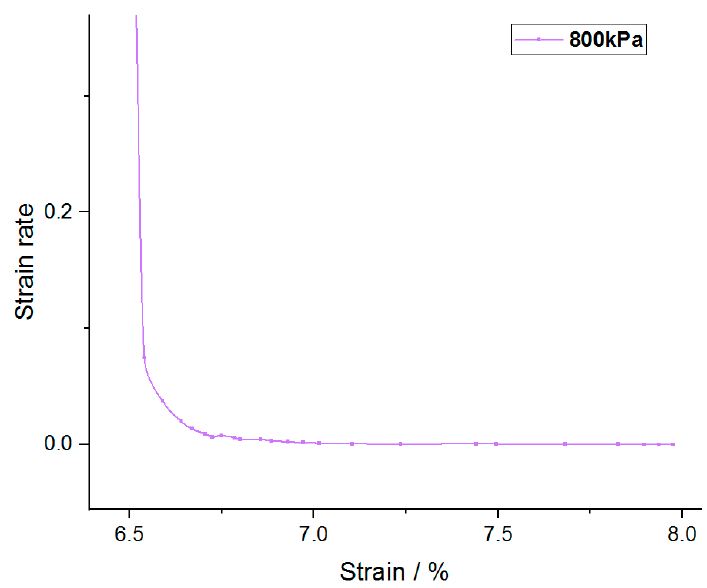
Figure 9. Enlarged view of end of strain rate–strain curve.